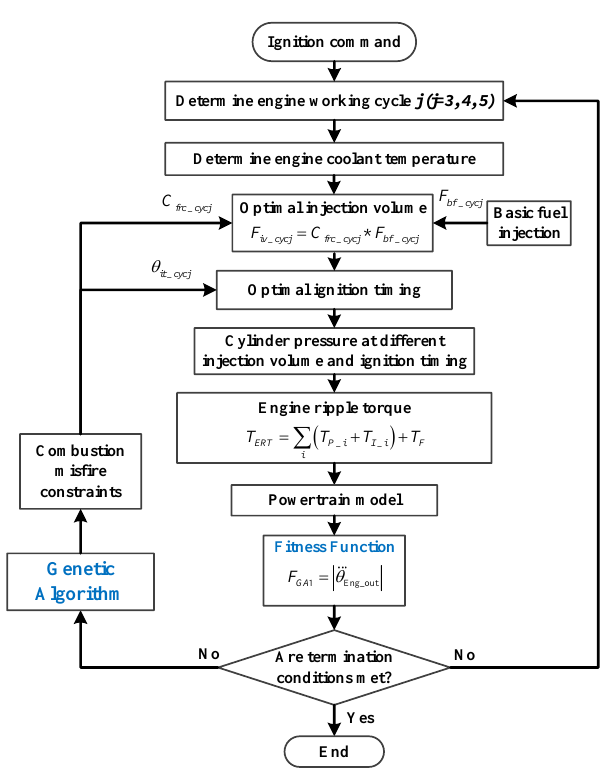
Figure 13. Flow diagram of the fuel injection and ignition timing optimization.